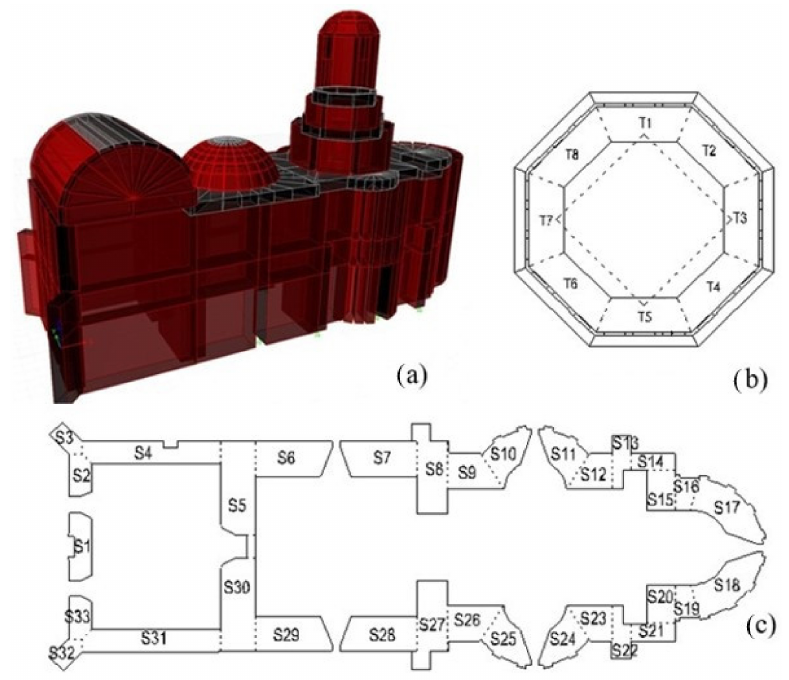
Figure 6. Numerical model: ( a ) Isometric view, ( b ) Structural elements distribution—tower level, ( c ) Structural elements distribution—church